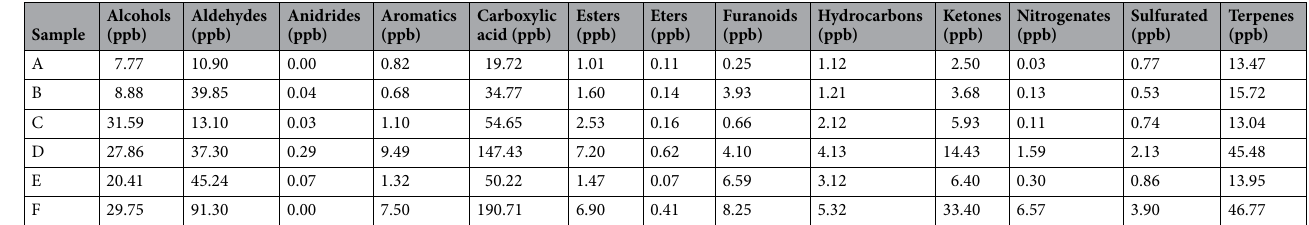
Table 2. Total volatiles compounds divided for chemical group. Data are expressed in